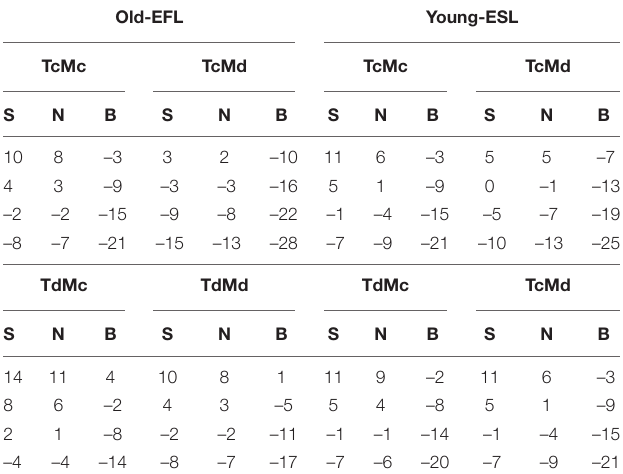
(T C , T d ), six participants were tested with a diffused masker (M d ) for the first 12 lists, and then with a compact masker (M C ) for the remaining 12. The reverse order was applied for the other six participants. Sentence lists and SNRs were counterbalanced across participants such that each list was presented at each of the 4 different SNRs an equal number of times within each group.